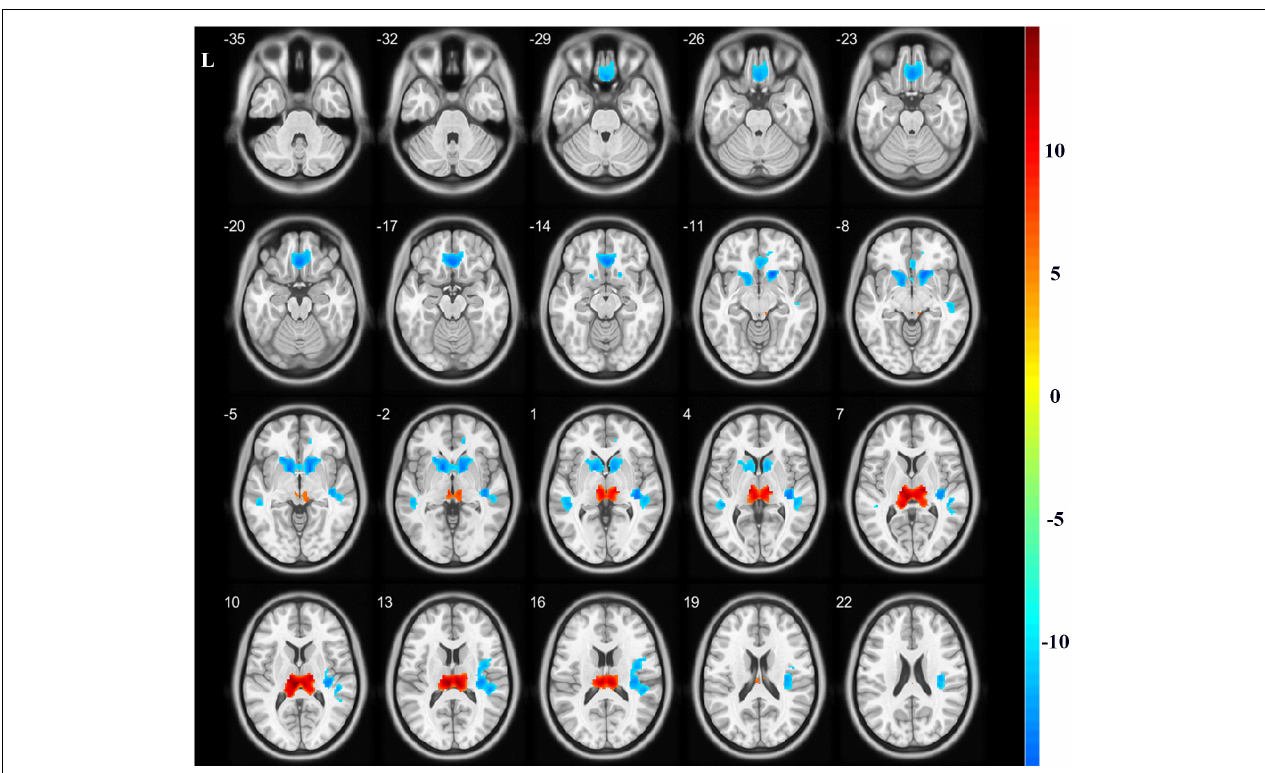
FIGURE 1 | Gray matter volume alterations between the two groups. Compared with the healthy controls, the bilateral thalamus indicated significantly increased volumes in the hemodialysis group compared with those noted in the healthy subjects (hot color). The bilateral rectus, bilateral caudate, and temporal gyrus indicated significantly decreased volumes (cold color). Color bar indicated t- value between hemodialysis and healthy control groups. The significance threshold was set at P < 0.05 corrected for multiple comparisons with familywise error correction at the voxel level.